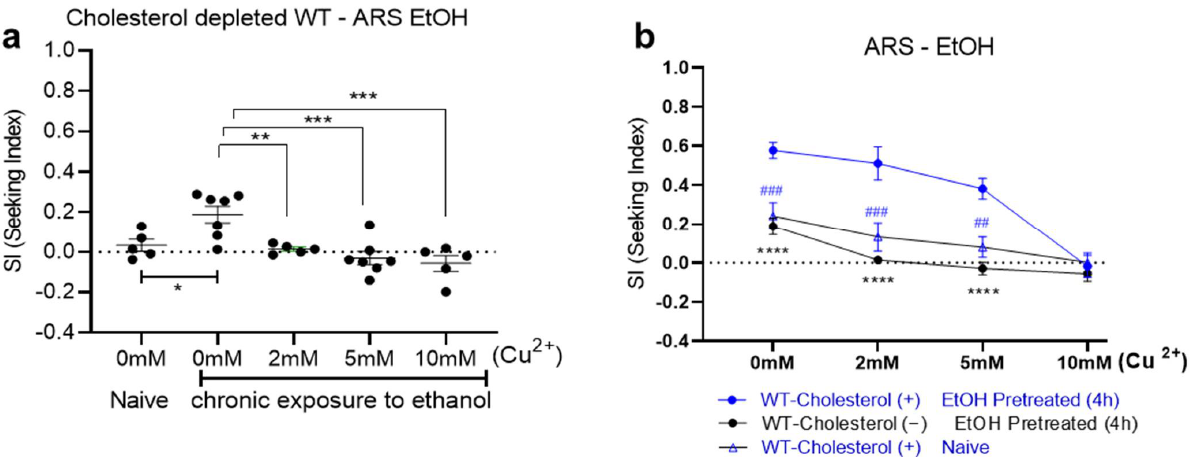
Figure 2. Behavioral quantification of ethanol preference and ARS of cholesterol-depleted WT animals (ARS: aversion-resistant seeking). ( a ) Strength of ethanol seeking is represented by the SI under different concentrations of a copper barrier (no barrier, 2 mM, 5 mM, and 10 mM). Compared to naïve WT animals grown in cholesterol-depleted conditions, cholesterol-depleted WT animals after ethanol pretreatment for 4 h developed ethanol preference. They showed mild chemotaxis to ethanol in the assay plate without an aversive barrier. However, few cholesterol-depleted WT animals crossed over aversive barriers. One-way ANOVA, p = 0.0002, F (4, 24) = 8.454, post hoc multiple comparison test; Dunnett’s ( p < 0.05, *; p < 0.01, **; p < 0.001, ***). Each dot represents an assay that used a population of 100–150. ( b ) Data sets ( a ) from cholesterol-depleted animals were compared to those of the control group: cholesterol-fed WT animals. Cholesterol-fed WT animals developed ethanol preference and ARS after chronic exposure to ethanol, whereas the developments of ethanol preference and ARS were impaired in cholesterol-depleted WT animals. [Fcholesterol (1, 48) = 78.93, p < 0.0001; Fconc (3, 48) = 24.32, p < 0.0001; Fcholesterol x conc (3, 48) = 7.122, p = 0.0005]. N numbers were [0 mM = 10, 2 mM = 6, 5 mM = 6, 10 mM = 10 for WT cholesterol-fed; 0 mM = 7, 2 mM = 5, 5 mM = 7, 10 mM = 5 for WT cholesterol-depleted; and 0 mM = 6, 2 mM = 5, 5 mM = 6, 10 mM = 6 for WT cholesterol-fed naïve]. A two-way ANOVA comparison showed significant differences based on cholesterol feeding, barrier concentration, and the interaction of the two. Significant post hoc differences (multiple comparison correction using the Bonferroni method) between the cholesterol feedings (fed vs. depleted) at no barrier, the 2 mM barrier, and the 5 mM barrier are shown ( p < 0.0001, ****). Significant post hoc differences (Bonferroni’s multiple comparison test) between naïve vs. ethanol-treated at no barrier, the 2 mM barrier, and the 5 mM barrier are shown ( p < 0.01, ##; p < 0.001,